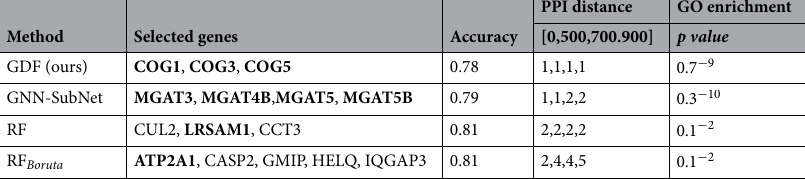
Table 5. Cancer type experiment. Accuracy of the selected kidney cancer (KIRC) genes. GO term enriched genes are highlighted in bold. The PPI Distance reflects the longest shortest path from one node to the other, given a certain threshold for the confidence of the